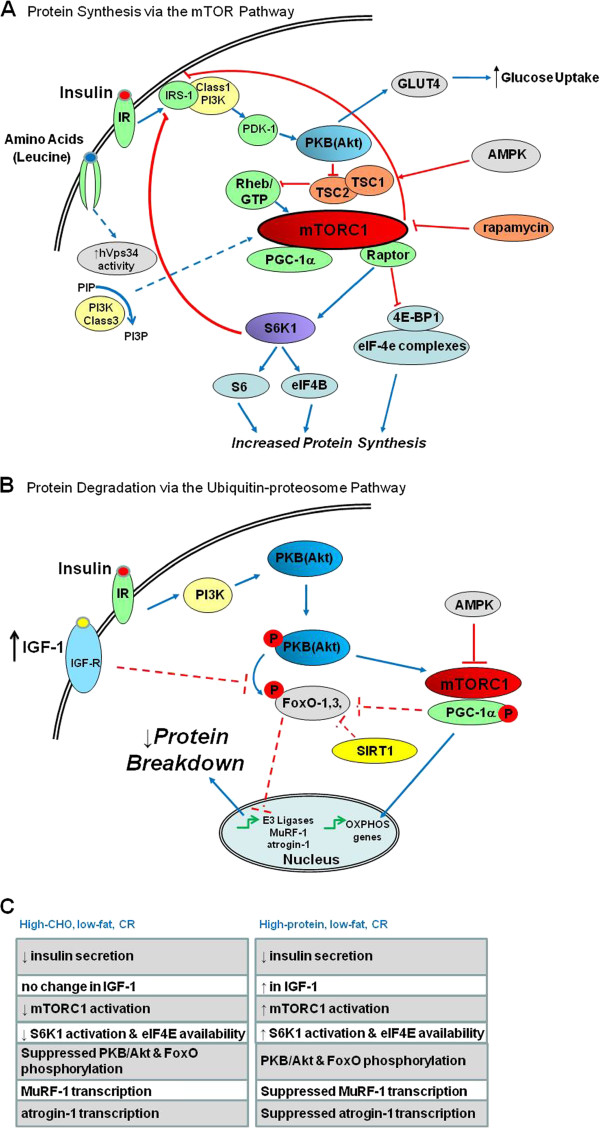
 A schematic representation depicting A; the protein synthesis pathway in skeletal muscle involving the mammalian target of rapamycin complex 1 (mTORC1). Insulin, and amino acids (including leucine) initiate activation of a cascade of protein and lipid kinases ultimately resulting in enhanced mTOR activity, facilitating the phosphorylation of S6K1 and hyper-phosphorylation of 4E-BP, resulting in enhanced availability of eIF4E for binding eIF4G and forming an active eIF4F complex resulting in increased protein synthesis [adapted from Layman
[88], Anthony et al.[89], Drummond et al.[61], Um et al.[98] and Kimball
[90,93] and B; our proposed mechanism whereby high protein calorie restricted weight loss increases IGF-1 activating the PI3K/Akt pathway, thereby phosphorylating (P) FoxO transcription factors and down-regulating the expression of E3 enzymes atrogin-1 and MuRF-1, leading to a reduction in protein degradation in skeletal muscle cells. PGC-1α, SIRT1 and AMPK are also proposed to inhibit the expression of FoxO transcription factors and therefore suppress protein breakdown [adapted from Lecker et al.[70], Bodine et al.[99], Anthony et al.[89] and Blagosklonny et al.[62]. Dashed lines indicate an interaction with an unknown mechanism. Red lines indicate an inhibitory signal to the pathway, and C; Summarisation of protein biosynthetic and degradation events following standard protein, high carbohydrate compared to high protein, calorie restricted weight loss.